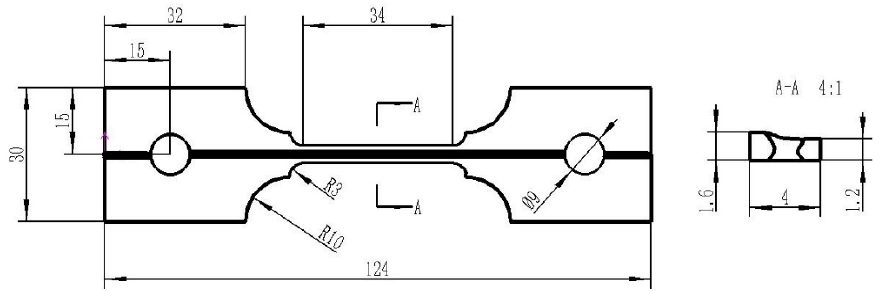
Figure 3. Geometry and dimensions of tensile samples.